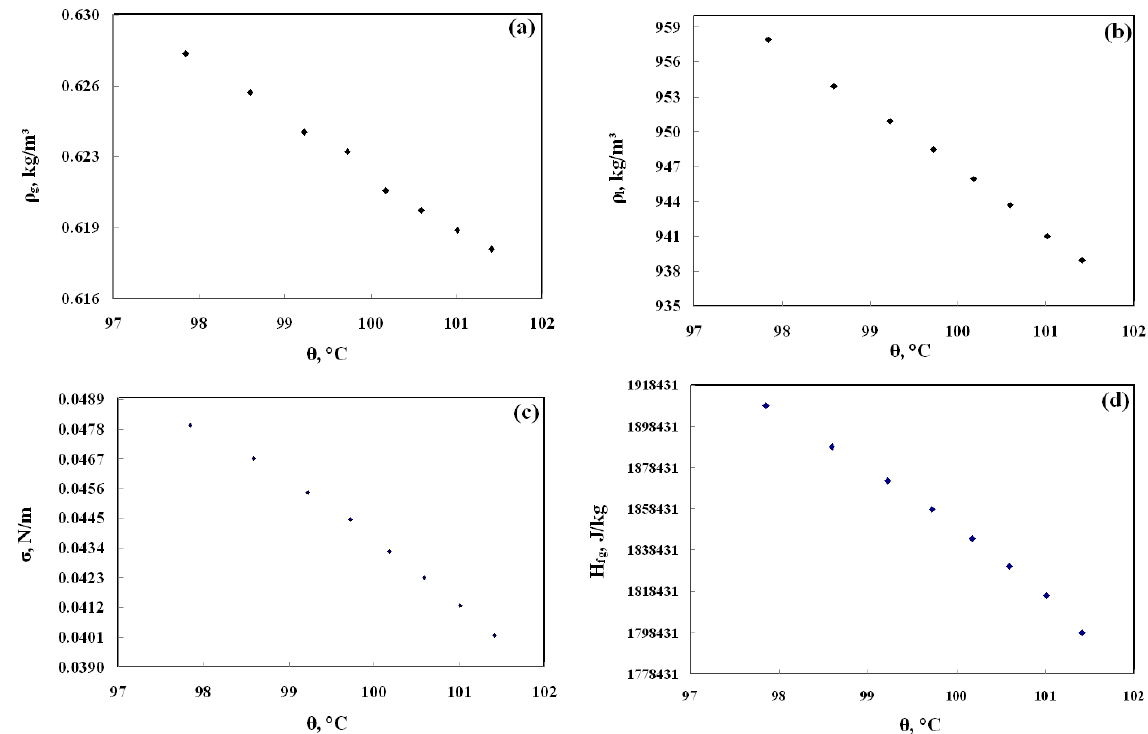
Figure 3: The amounts of a) liquid density, b) vapor density, c) surface tension, and d) vaporization enthalpy of water-ethanol solution (3% by volume) at different